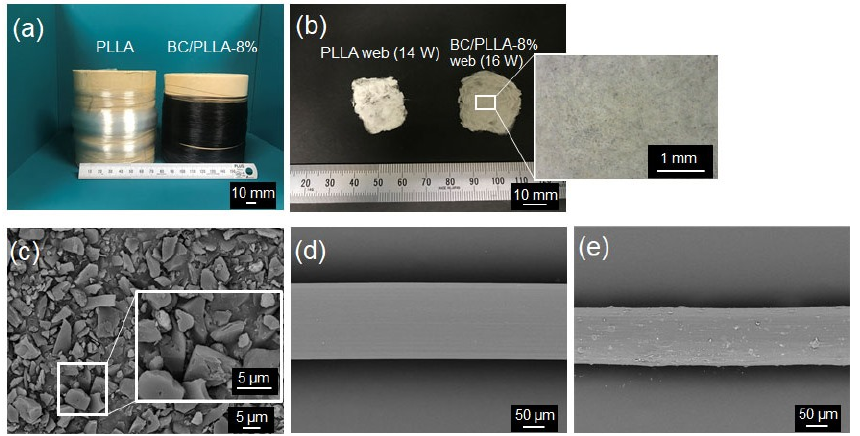
Figure 6. Images of ( a ) raw PLLA and BC/PLLA fibers and ( b ) electrospun PLLA (14 W) and BC/PLLA (16 W) webs and scanning electron microscopy (SEM) images of ( c ) BC, ( d ) raw PLLA fibers, and ( e ) raw BC/PLLA